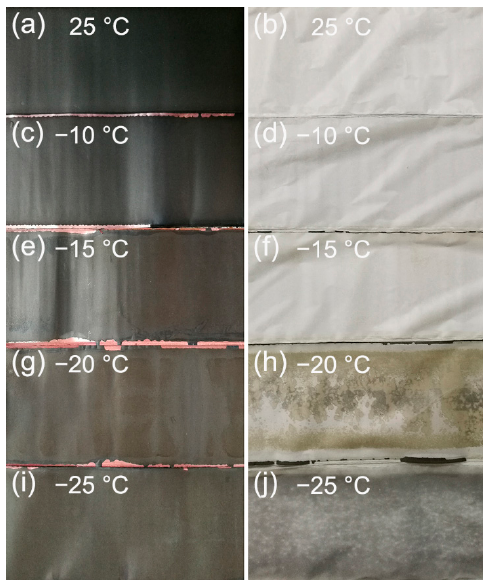
Figure 8. Photographs of the anode surfaces (left side) and separator surfaces (right side) dismantled from the 18650 lithium-ion battery cells after charging at 1 C, and the environmental temperatures were set to ( a , b ) 25 °C, ( c , d ) − 10 °C, ( e , f ) − 15 °C, ( g , h ) − 20 °C and ( i , j ) − 25 °C. Energies 2019 , 12 FOR PEER REVIEW